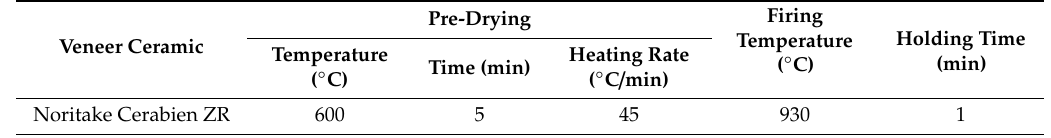
Table 6. Sintering schedule of veneer ceramic material.